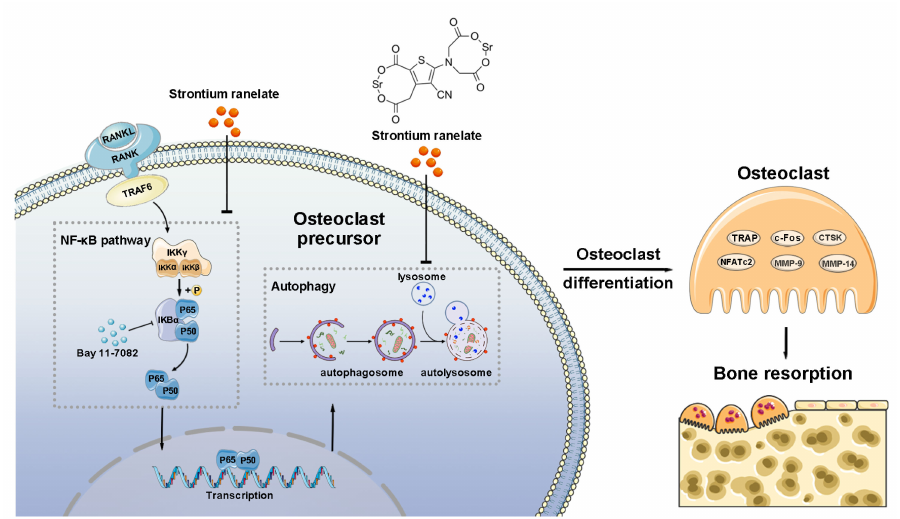
Figure 7. Schematic illustration of the mechanism of how SR suppresses osteoclastogenesis by inhibiting autophagy through the NF- κ B